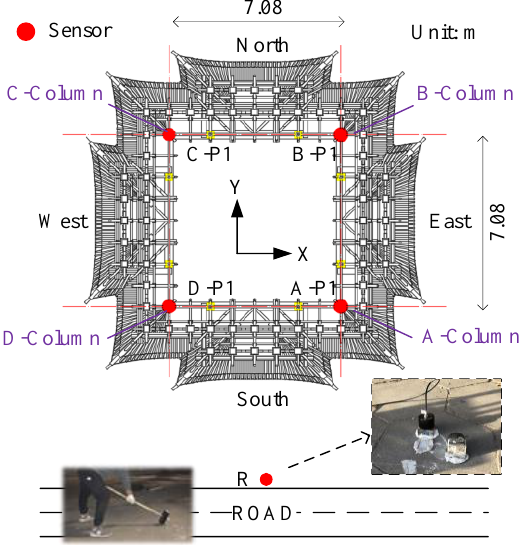
sensors in horizontal east − west, horizontal north − south direction, and vertical direction. The sampling frequency is set equal to 512 Hz.